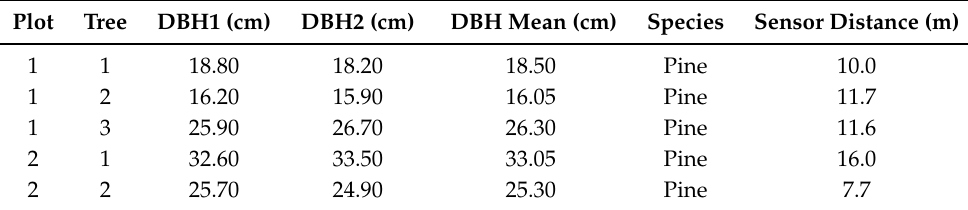
Table 2. Stem profile evaluation